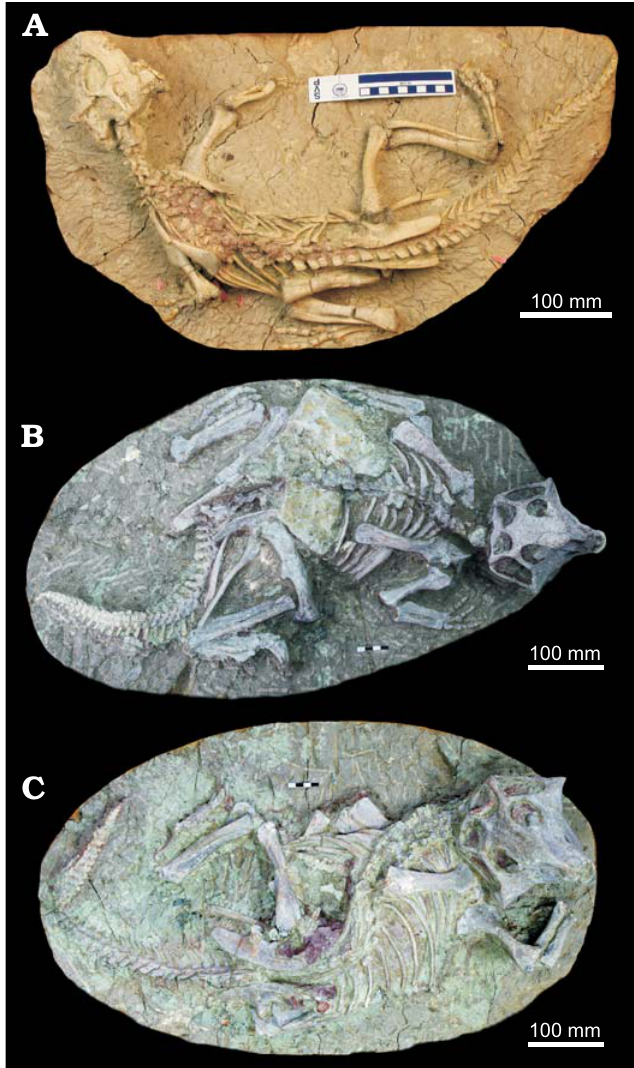
Fig. 5. The skeletons of ceratopsian dinosaur Psittacosaurus lujiatunen- sis Zhou, Gao, Fox, and Chen, 2006 subadult (IVPP V14748, A ; IVPP V18344, B ) and adult P. lujia tunensis (IVPP V18343, C ) from western Liaoning, China, Early